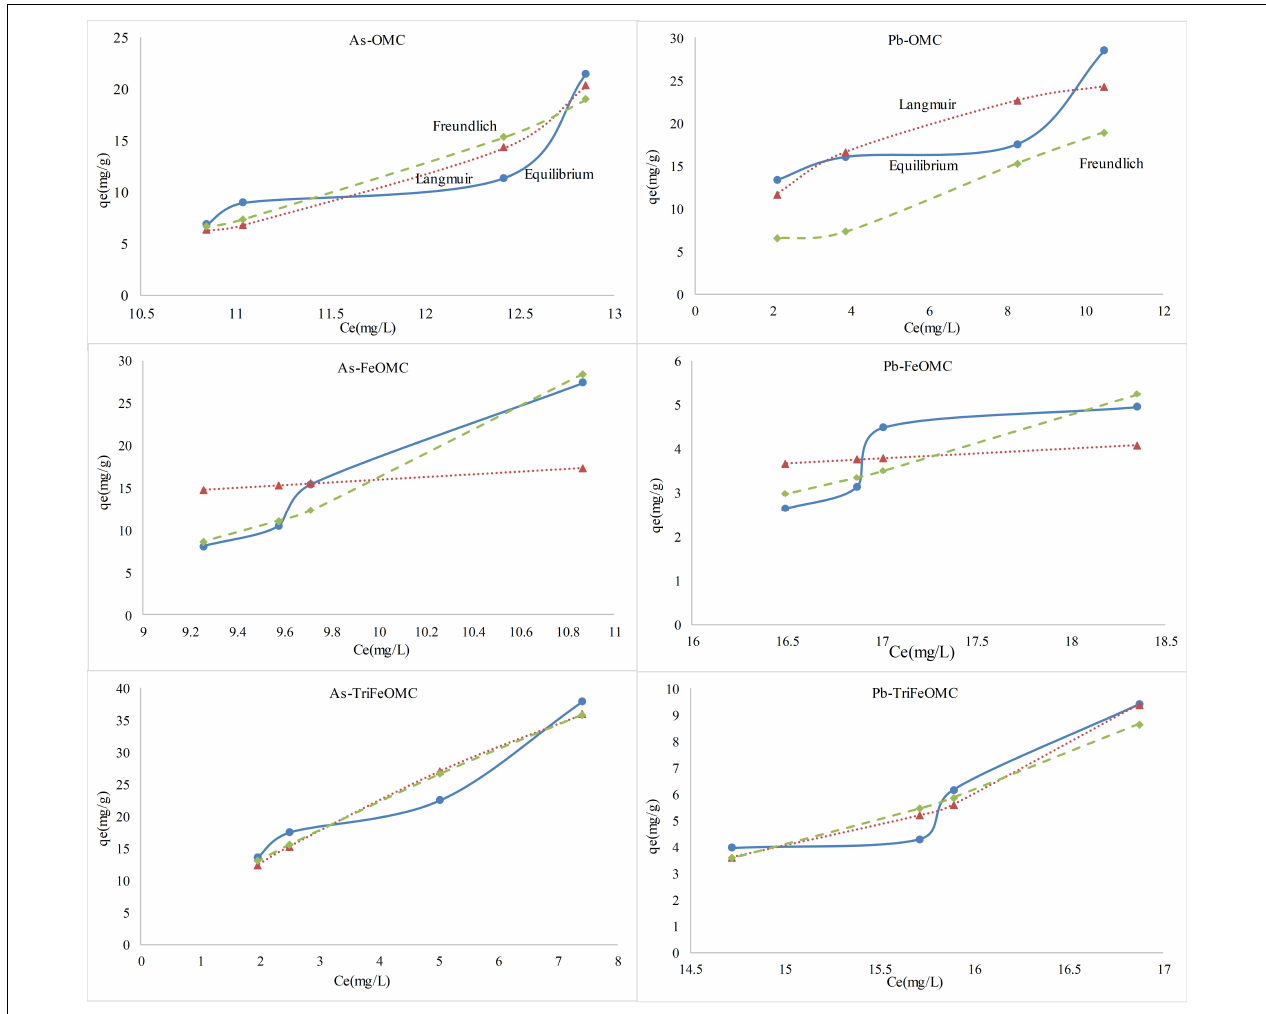
FIGURE 9 | Langmuir and Freundlich isotherms of As and Pb for OMC, FeOMC, and TriFeOMC.